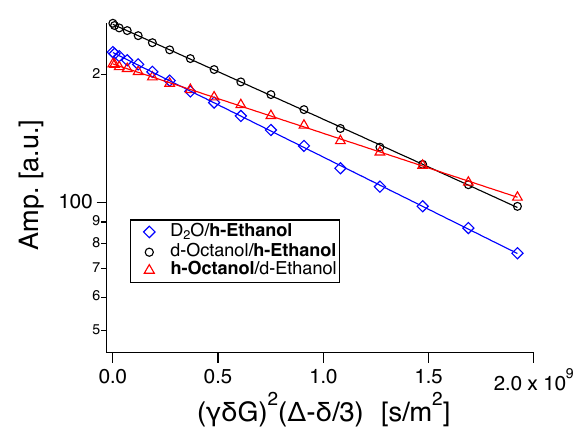
Figure 2. PFG-NMR amplitudes as a function of pulsed field gradient and fit with a single exponential function. The hydro- genated component of the binary mixture, accounting for the largest part of the signal, is in bold in the